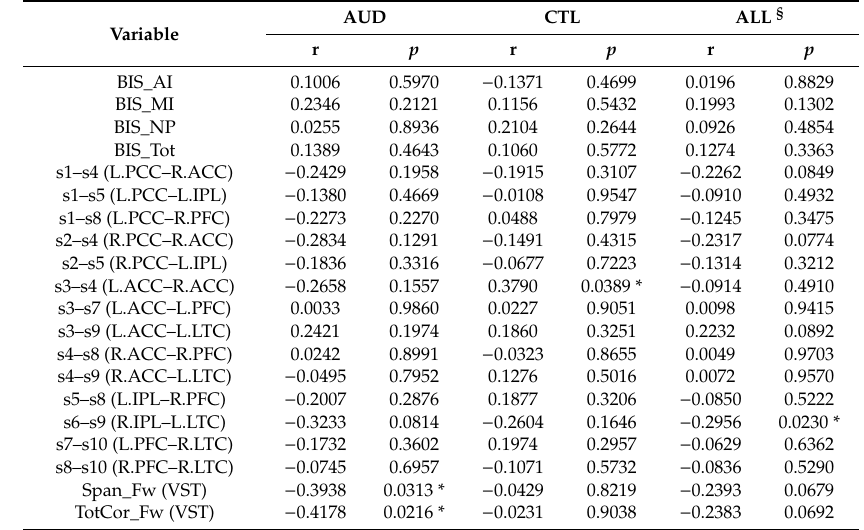
Table 4. Correlations between the age of the participant and the significant variables in each group and the total